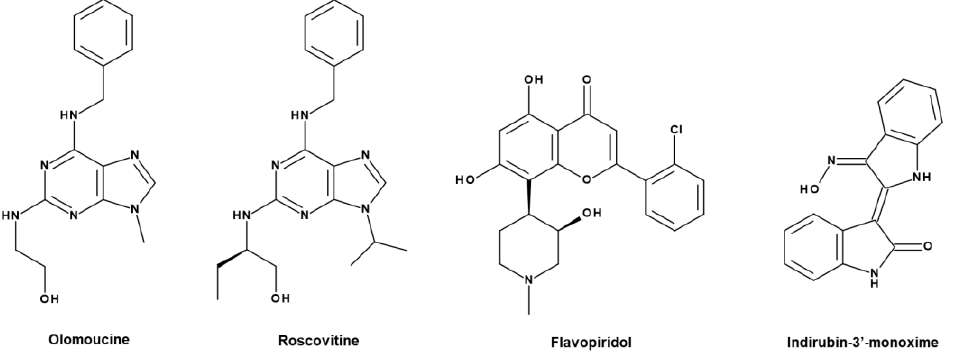
Figure 5. Structures of CDK5 inhibitors: roscovitine, flavopiridol, dinaciclib, olomoucine, pur- valanol A, indurubin- 3′, 20 -223, AT7519. 5.1. Early Pan CDK Inhibitors Olomoucine, roscovitine, and flavipiridol belong to broad pan CDK inhibitors (Fig- ure 5) [218]. Olomoucine is a selective CDK5 inhibitor [218,219]. It inhibits CDK1 (IC 50 = 7 μ M), CDK2 (IC 50 = 7 μ M) and CDK5 (IC 50 = 3 μ M) (Table 4) [218]. Olomoucine induces apoptosis in human cancer [218,220]. The combination of olomoucine with androgen-an- tagonist bicalutamide exerts the synergic effect on prostate cancer cell lines [221]. Table 4. IC 50 values of CDK5 inhibitors.